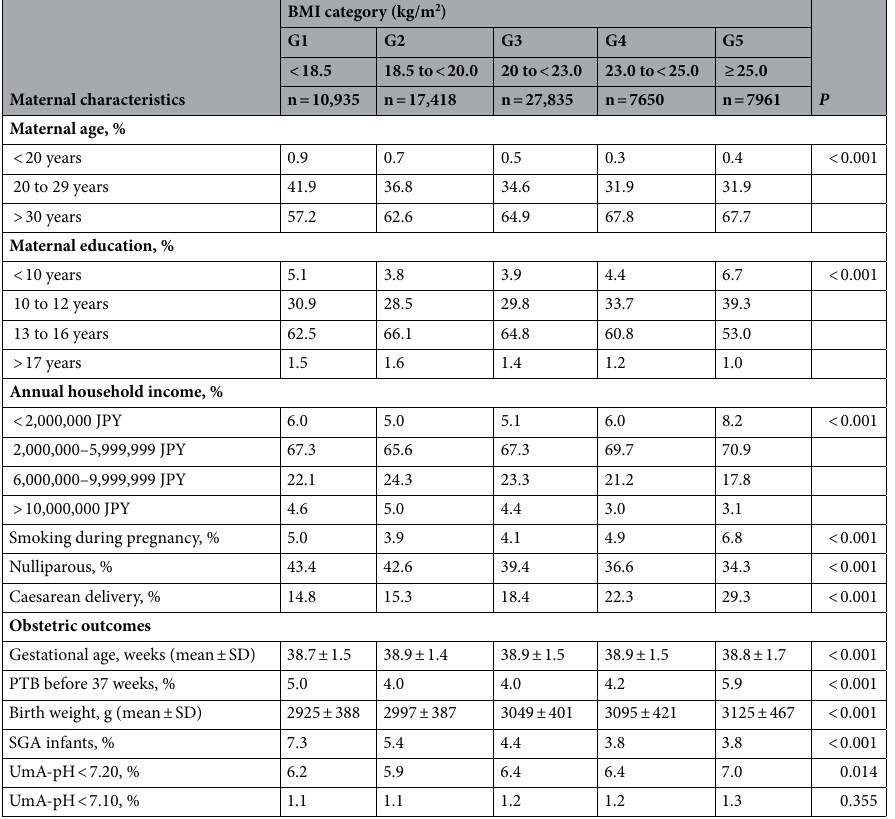
Table 1. Maternal characteristics and obstetric outcomes by pre-pregnancy BMI. One-way analysis of variance, Kruskal–Wallis test and the chi-square test were used to compare continuous and categorical variables, respectively. BMI, body mass index; JPY, Japanese yen; LBW, low birth weight; SGA, small for gestational age; SD, standard deviation; UmA-pH, umbilical artery pH.